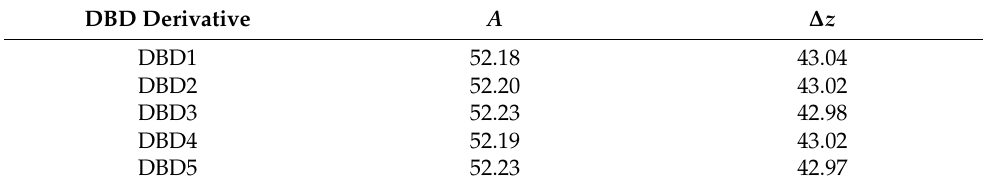
Table 1. Area/lipid A and thickness ∆ z of the systems simulated in this work, given in Å 2 and Å units, respectively. Estimated errors based on standard deviations correspond to the last significant figures, i.e., ± 0.01 in each